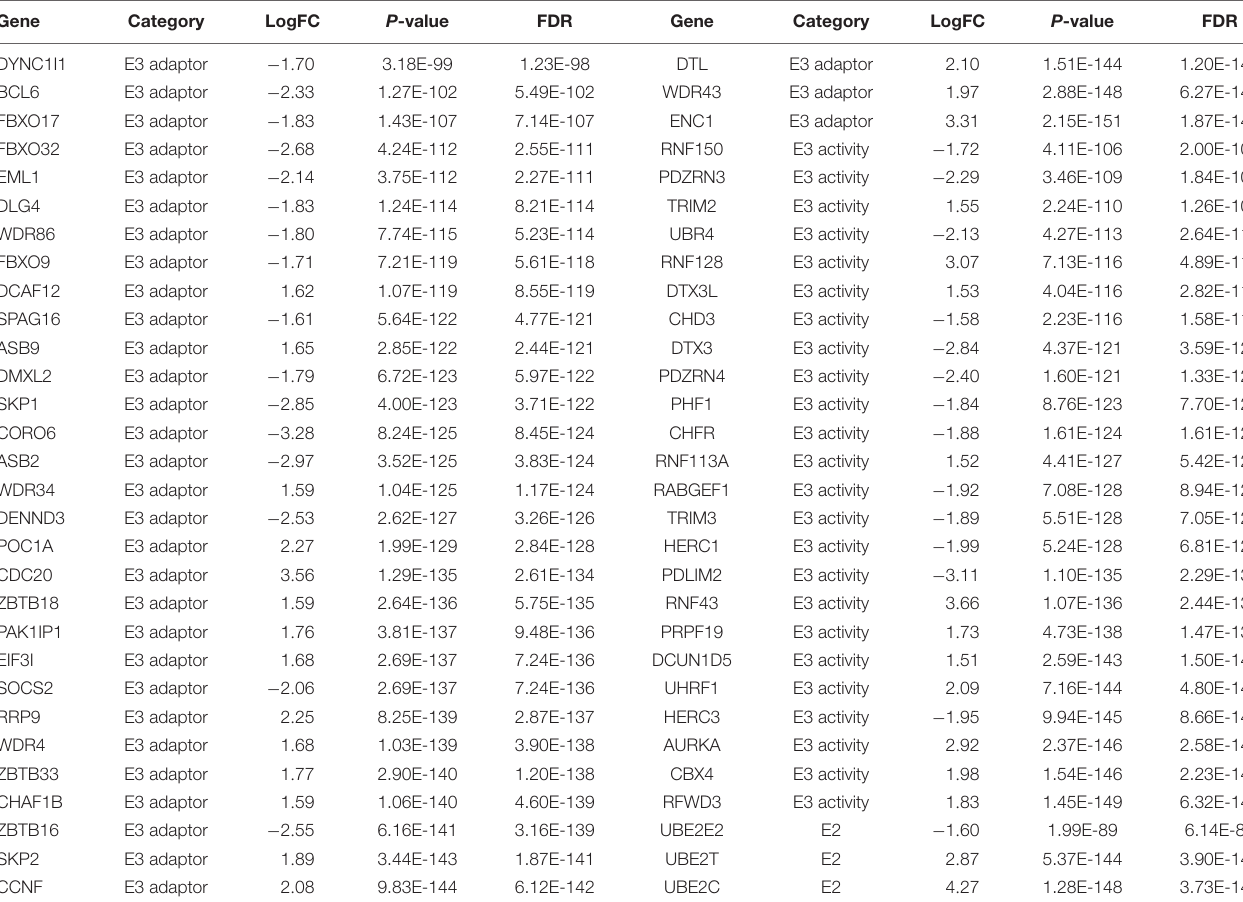
TABLE 1 | The results of the differential analysis when comparing normal colon samples in GTEx plus CRC-adjacent normal samples with CRC samples in TCGA. Gene Category LogFC P -value FDR Gene